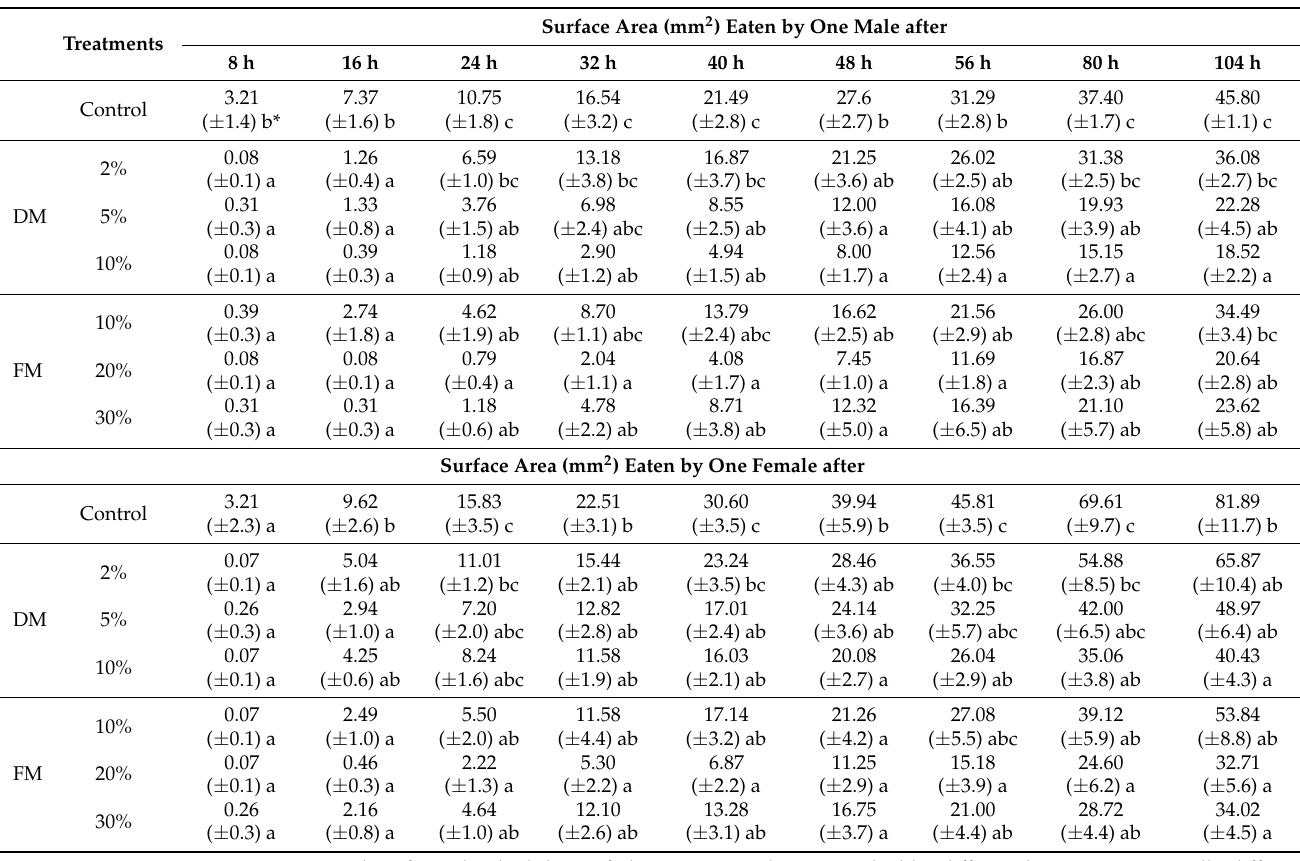
* Values for individual dates of observations and sexes marked by different letters are statistically different ( α =